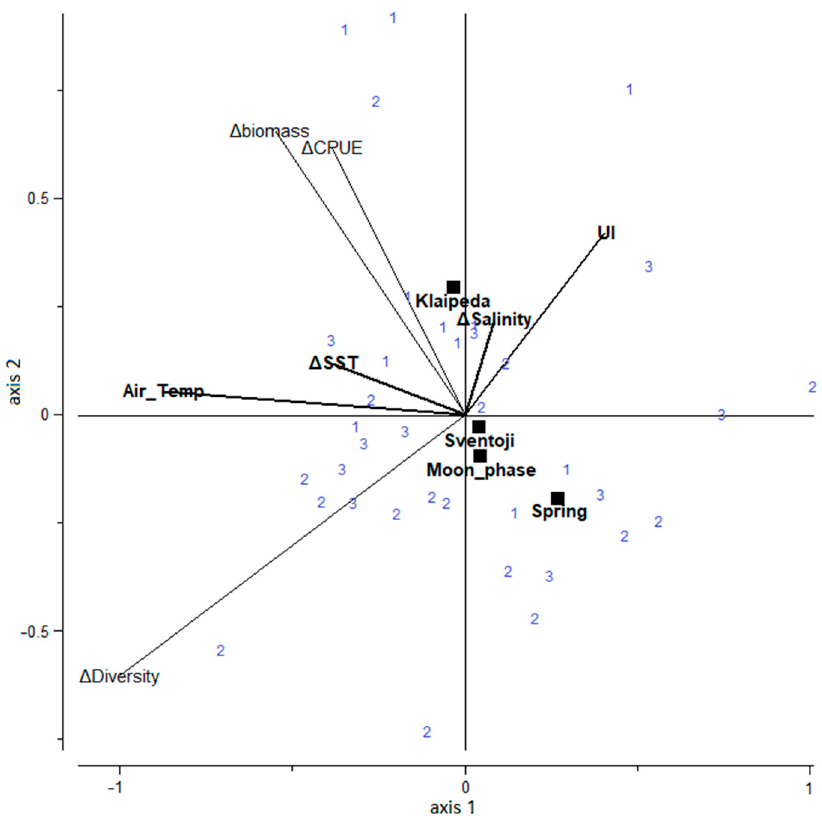
Figure 5. RDA triplot for coastal fish assemblage characteristics (changes in total CPUE abundance ( Δ CPUE), biomass and diversity index) with upwelling (UI, Δ SST, Δ Salinity) and other environmental parameters such as air temperature, and the moon phase, sampling location (Klaipeda, Karkle, and Sventoji) and sampling period (spring and summer) used as nominal explanatory variables. The numbers refer to the fish assemblages from different locations: 1 − Klaipeda, 2 − Karkle, 3 − Sventoji.